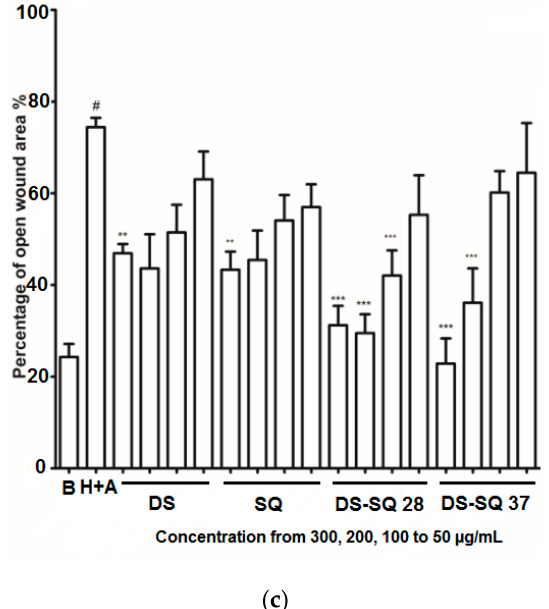
Figure 2. DS, SQ and DS-SQ on EAhy 926 endothelial cell wound scratch assay. The photos of EAhy926 cells with treatment of DS, SQ, DS-SQ 2:8 or DS-SQ 3:7 after wounding at 0 h and 24 h were taken and segmented automatically by TScratch, with identical settings for bright-field acquired. The percentage of the open wound area for each sample generated by TScratch was recorded and the percentage of open wound area was calculated by: the percentage of open area at 24 h ( a ) EAhy 926 cells with medium only after wounding at 0 h (top-left) and 24 h (bottom-left) and the cells treated with Hcy and Ado at 0 h (top-right) and 24 h (bottom-right); ( b ) EAhy 926 cells co-incubated with DS, SQ, DS-SQ 2:8 and DS-SQ 3:7 at 300 µ g/mL after wounding at 0 h (top) and 24 h (bottom) and Hcy-Ado; ( c ) Statistical analysis for DS, SQ and DS-SQ 2:8 and 3:7 on wound healing activities in EAhy 926 cells induced by Hcy and Ado. “H+A” represents Hcy and Ado stimulation. All results were expressed as mean ± S.E.M. from three separate experiments. # p < 0.05 compared with blank. * p < 0.05 compared to Hcy plus Ado treated group. ** p < 0.01 compared to Hcy plus Ado treated group. *** p < 0.001 compared to Hcy plus Ado treated group.